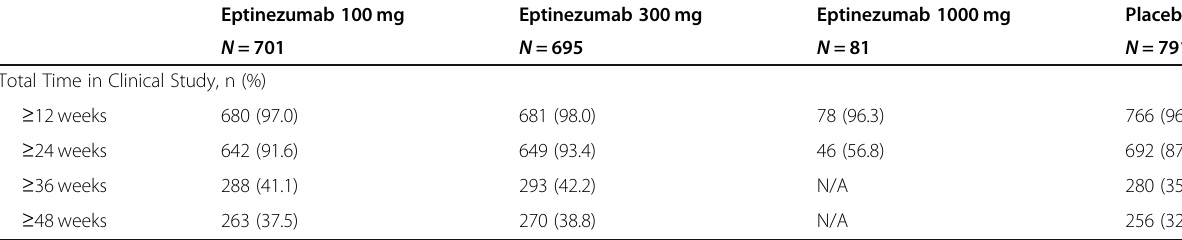
Table 3 Clinical Study